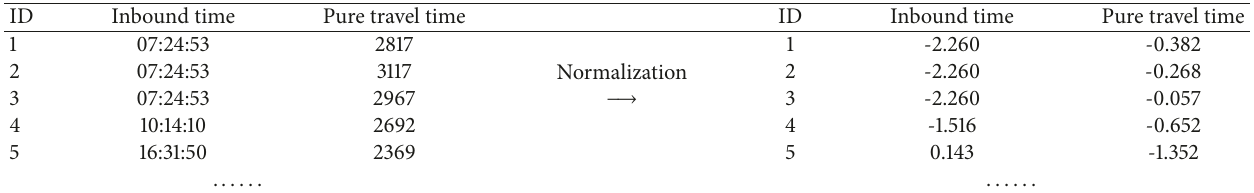
Table 3: Data normalization.